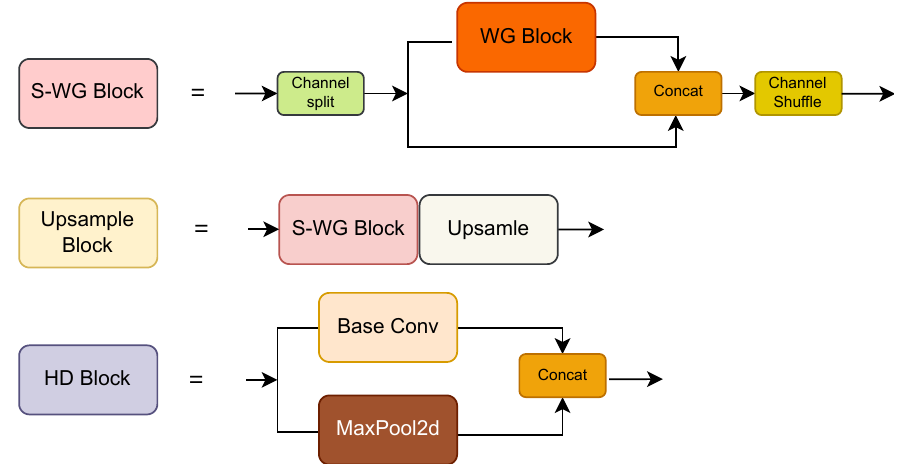
Figure 5. The structures of the S-WG, upsample, and HD blocks in the S-PANet. After using the S-PANet, the parameters of our ODN were reduced from 7.93 M to 5.31 M, and the number of floating-point operations was reduced from 4.86 GFLOPs to 3.81 GFLOPs while ensuring the feature fusion ability of the proposed object detection